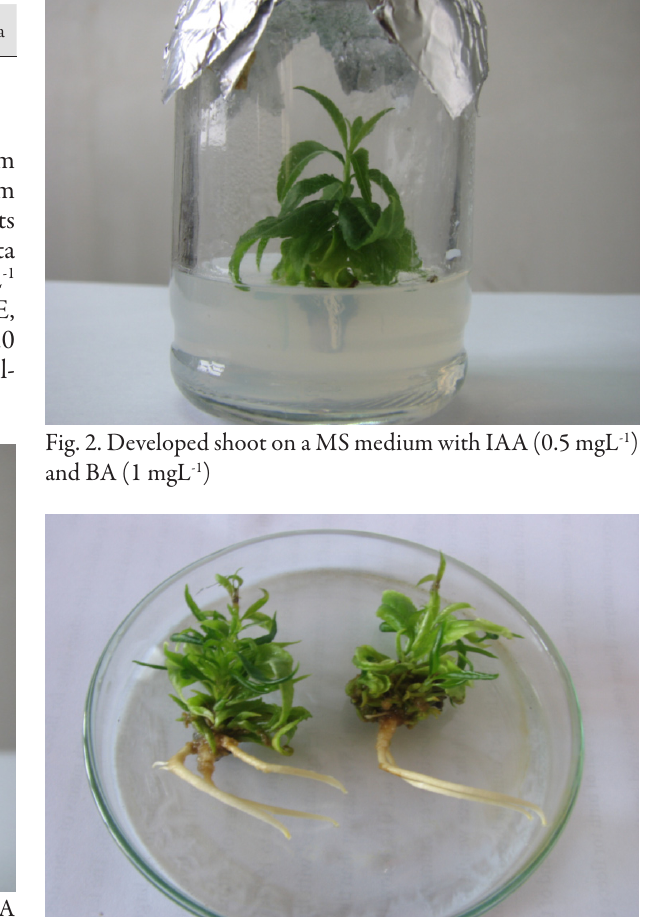
Fig. 3. Seedlings on MS medium with IBA (0.5 mgL -1